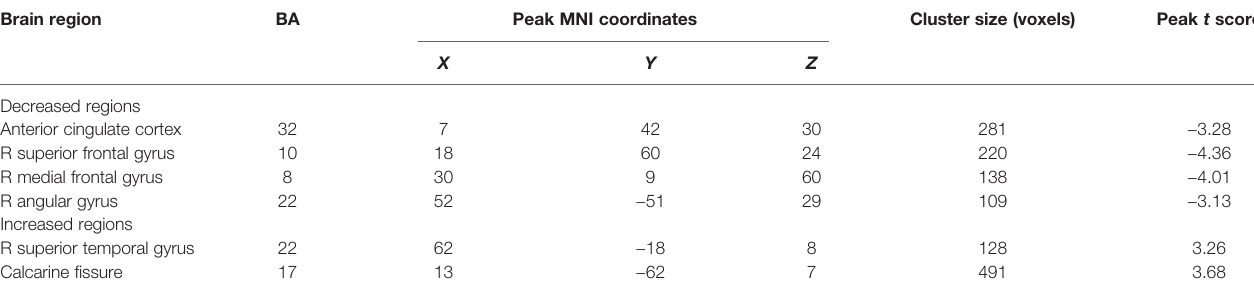
TABLE 2 | Abnormal functional connectivity of the PCC in type 2 diabetes patients without cognitive and microvascular complications compared with healthy controls. Brain region BA Peak MNI coordinates Cluster size (voxels) Peak t score X Y Z